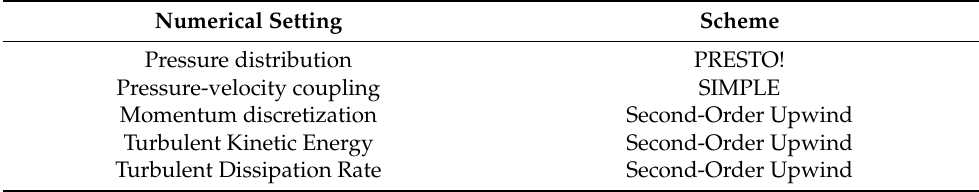
Table 3. Numerical scheme for